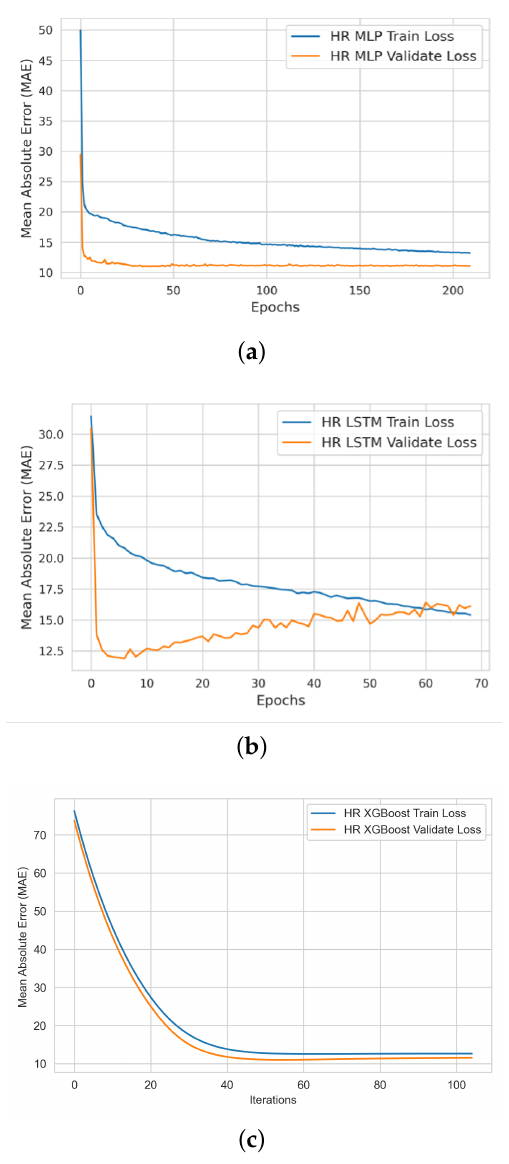
Figure 6. Heart rate ML models’ performance curves during the learning and validation of